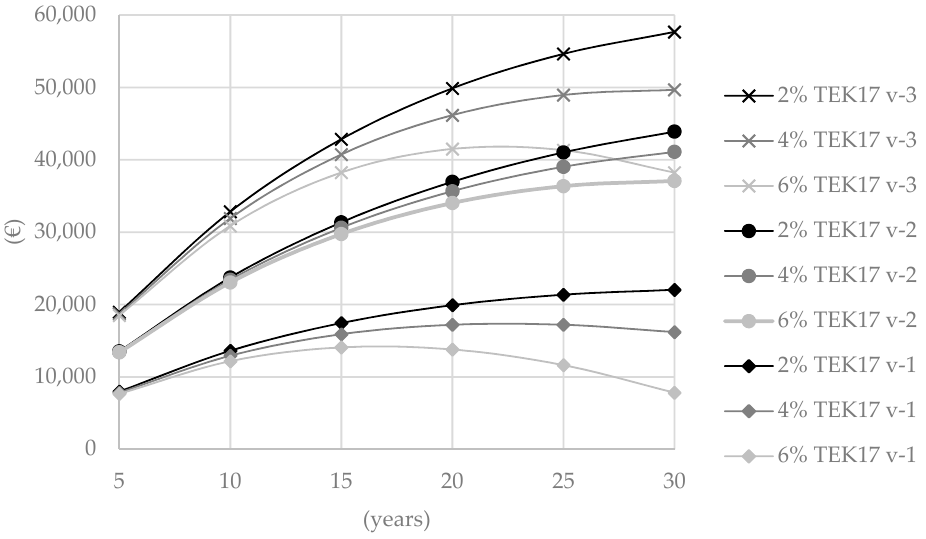
Figure 5. Interpolated and smoothed 5-year-step absolute difference between the NPV of the ZEB-COM and the NPV of the TEK17 variants.